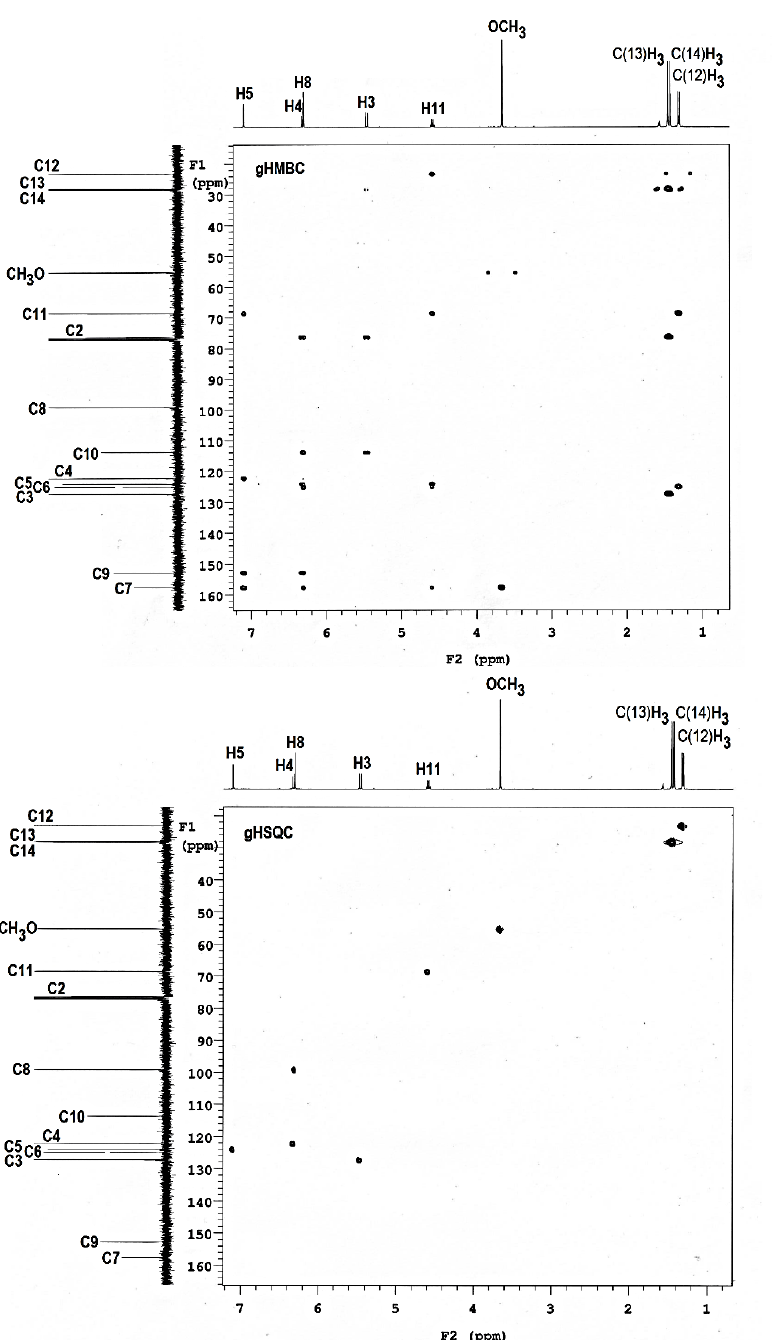
Figure 3. gHMBC and gHSQC spectra of ( ‒ )-encecanescin ( 1 ) in CDCl